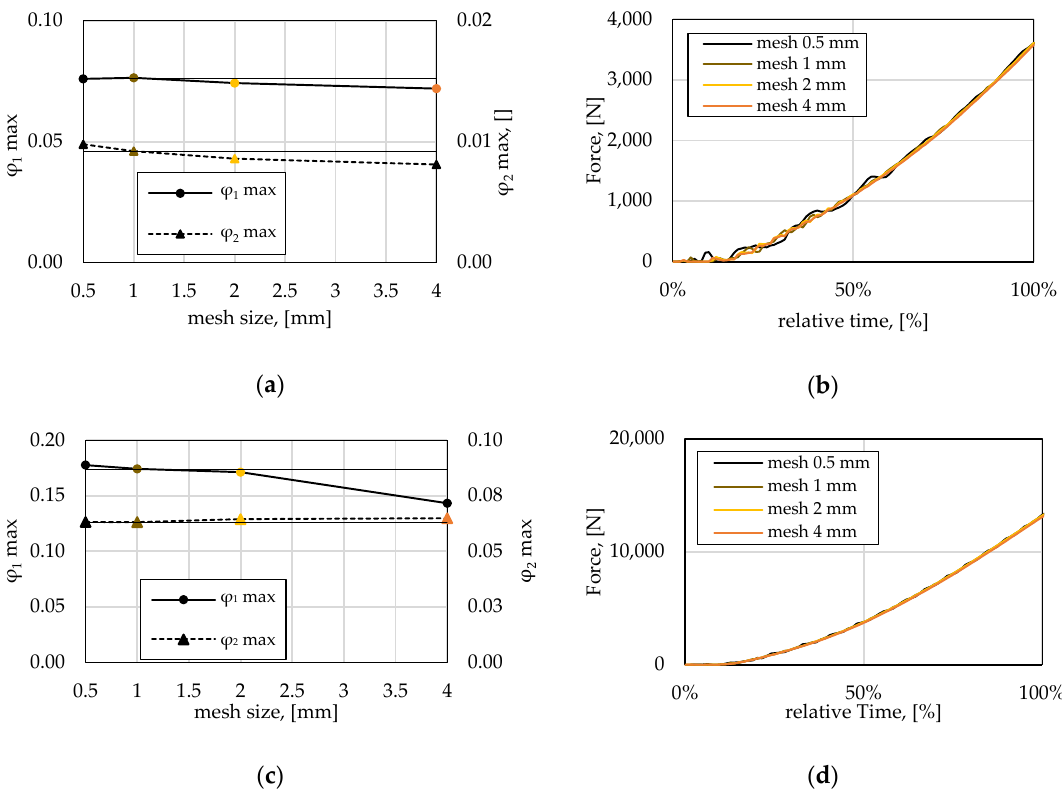
Figure 7. Convergence analysis for Nakajima100 ( a ) maximum occurring strain ( b ) punch force curve and limited dome height experiment ( c ) maximum occurring strain and ( d ) punch force curve.